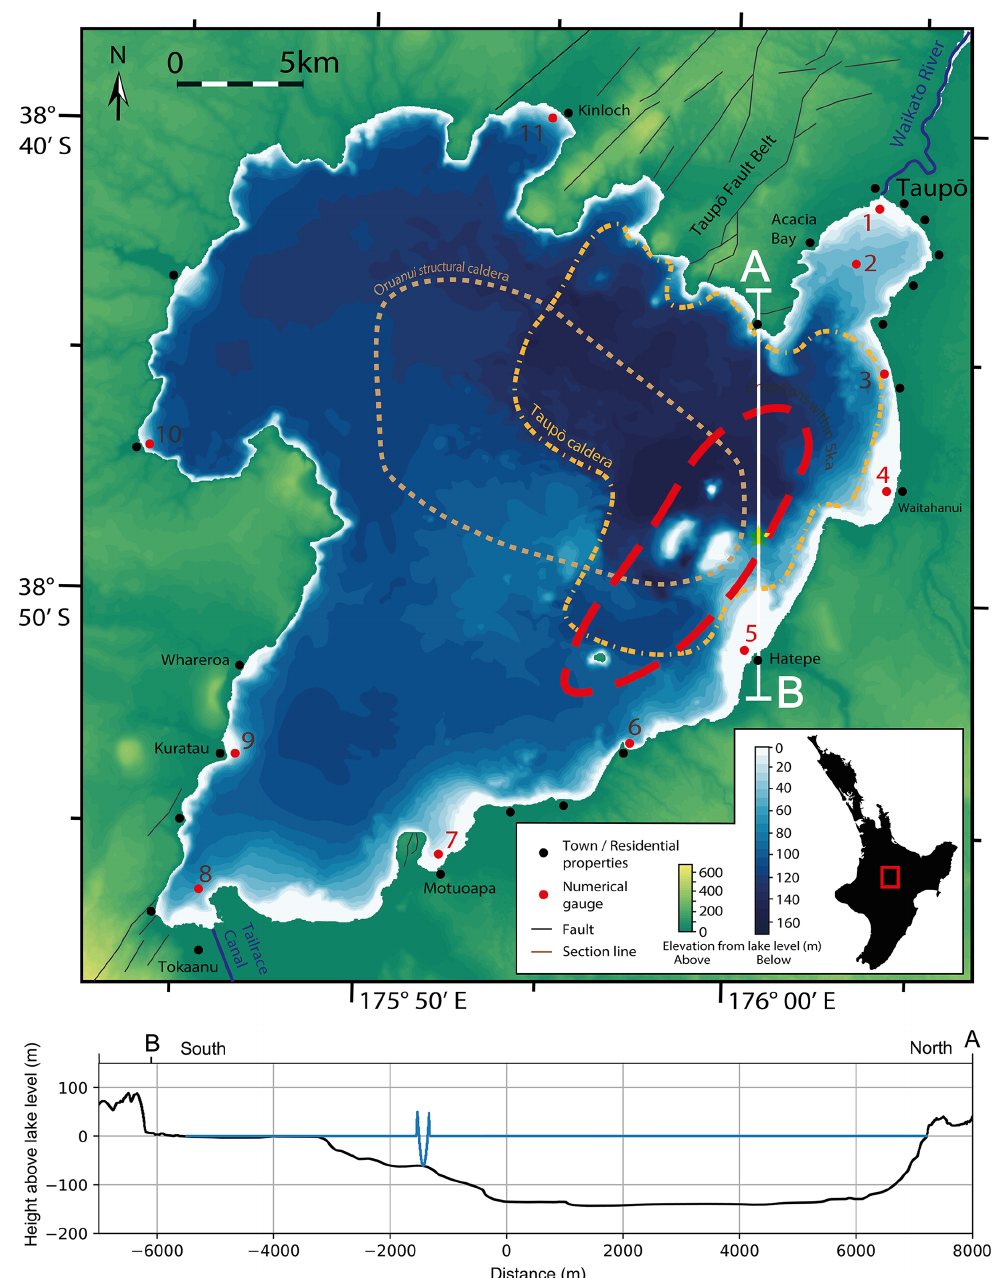
Figure 9. Lake Taup ¯ o setting with lake bathymetry, surrounding terrain, marked fault zones, and built-up areas. Also highlighted are the caldera zones of the Hatepe/Taup ¯ o eruption and the Oruanui super-eruption (Leonard et al., 2010). The dashed red area encloses area of activity within 5kyr from Wilson (1993) and Barker et al. (2015). The star indicates simulated eruption location at − 38.813 ◦ S, 176.016 ◦ E. Below is a cross-sectional profile of high-run initial condition with terrain elevation in a north–south direction in line with source